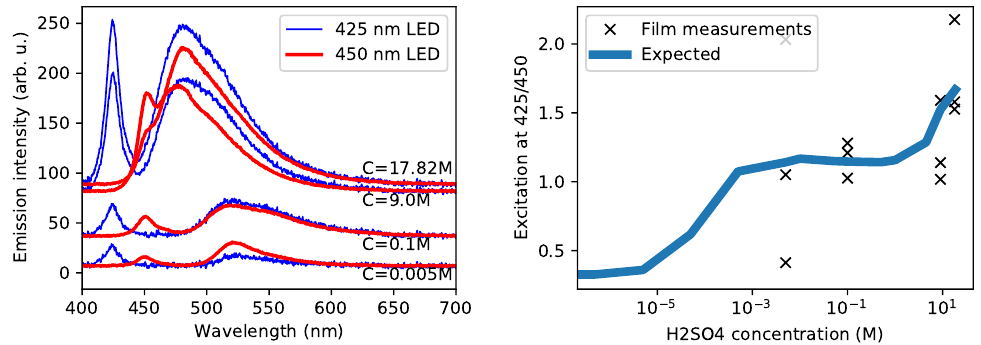
Figure 13. Measured spectra of droplets of various concentration on the sensing film. ( Left ): flu- orescence spectra obtained when illuminating droplets on the sensor film with a 425 and 450 nm LED. ( Right ): Relative intensities of fluorescence excitation at 425 nm compared to 450 nm. The expected values were obtained from liquid-phase measurements. The actual values are results of measurements performed on droplets on